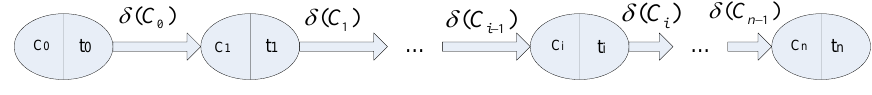
Fig. 4. The process of changing the domain model.